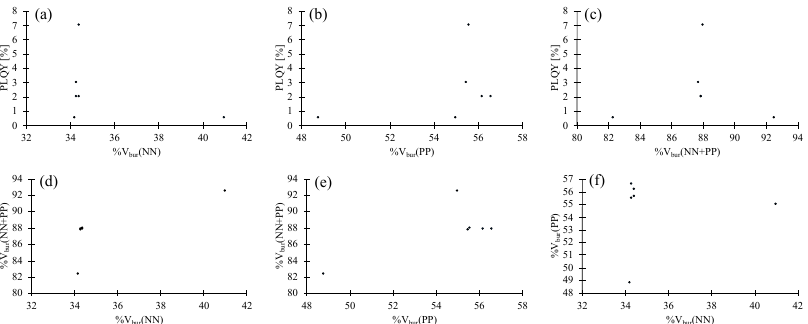
Figure 8. Scatter plots of PLQY, %V bur (NN), %V bur (PP) and %V bur (NN + PP) for compounds 8 – 12 [31]. ( a ) Scatter plot of PLQY vs. %V bur (NN). ( b ) Scatter plot of PLQY vs. %V bur (PP). ( c ) Scatter plot of PLQY vs. %V bur (NN + PP). ( d ) Scatter plot of %V bur (NN) vs. %V bur (NN + PP). ( e ) Scatter plot of %V bur (PP) vs. %V bur (NN + PP). ( f ) Scatter plot of %V bur (NN) vs. %V bur (PP).